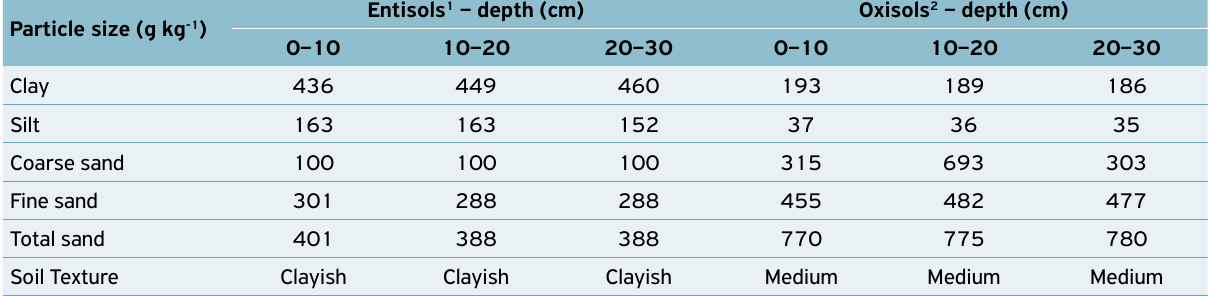
1 Clayish soil; 2 medium sandy